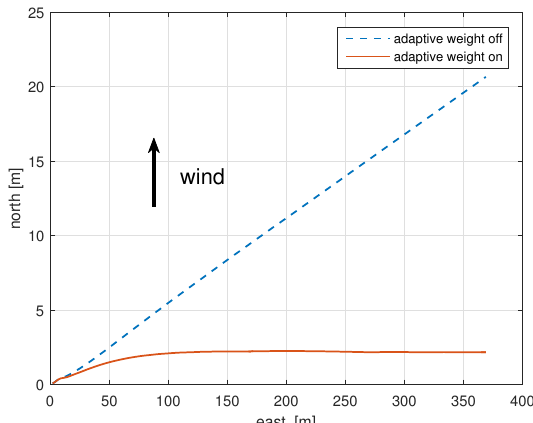
Figure 13. Sailing trajectory with and without adaptive weight term. The blue dashed line in the figure is the trajectory without adaptive weight term, and the solid orange line is the trajectory with adaptive weight term, when keeping a 90 + 1.5 degrees course in calm